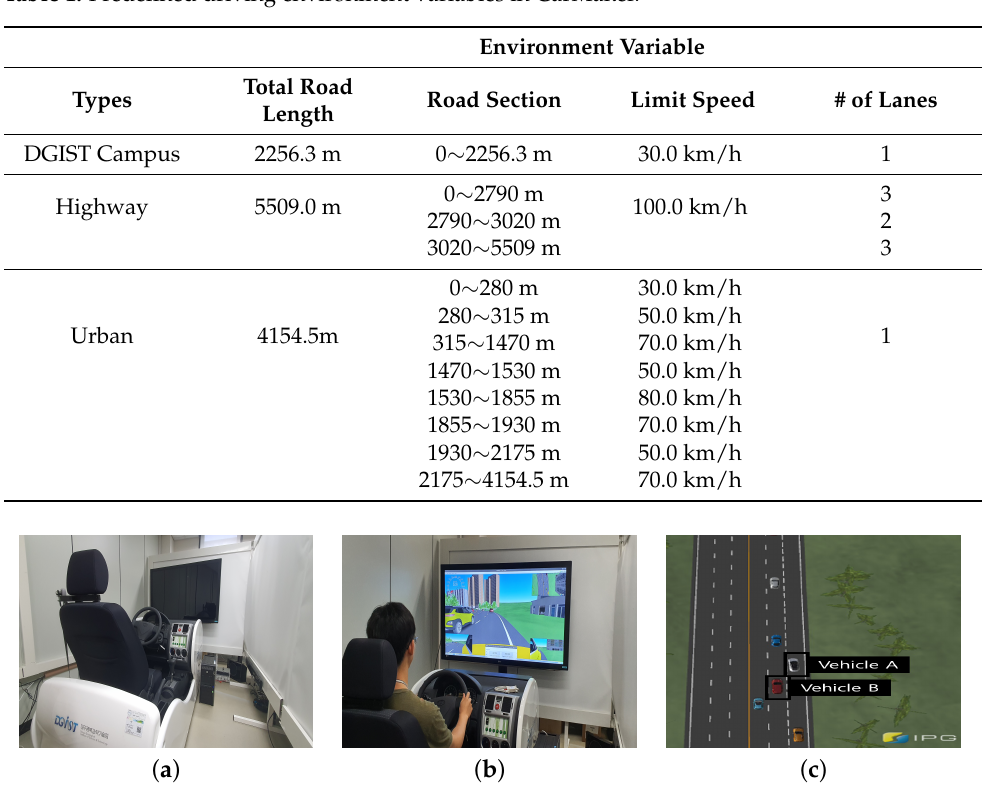
Table 1. Predefined driving environment variables in CarMaker.